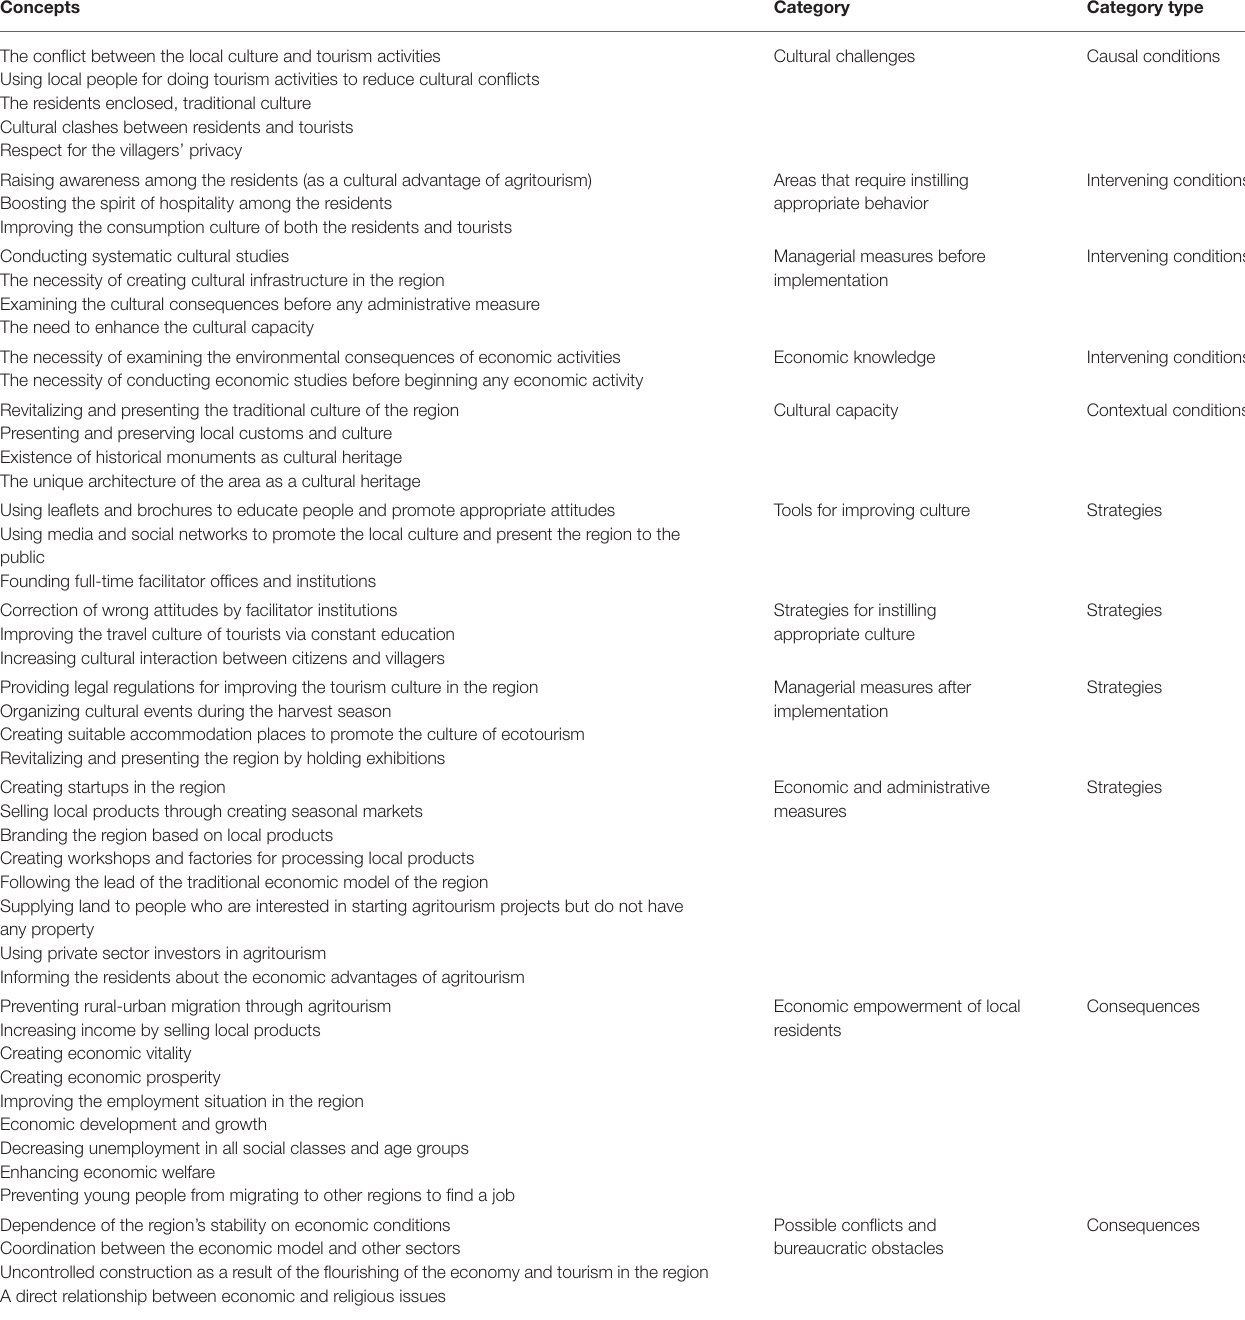
TABLE 2 | The final extracted categories and